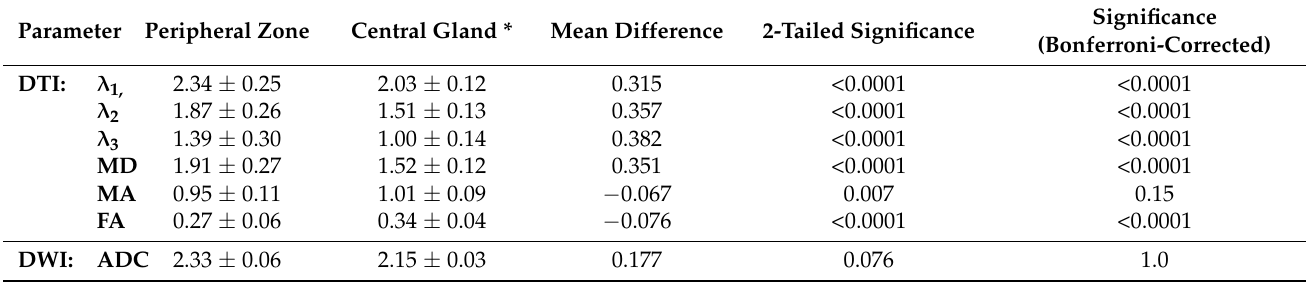
* Central gland-transitional zone and central zone. Values are presented as mean ± standard deviation. Significance is corrected for multiple comparisons according to Bonferroni, across Tables 2 and 3a,b. λ 1to3 , MD, MA, and ADC values presented in × 10 − 3 mm 2